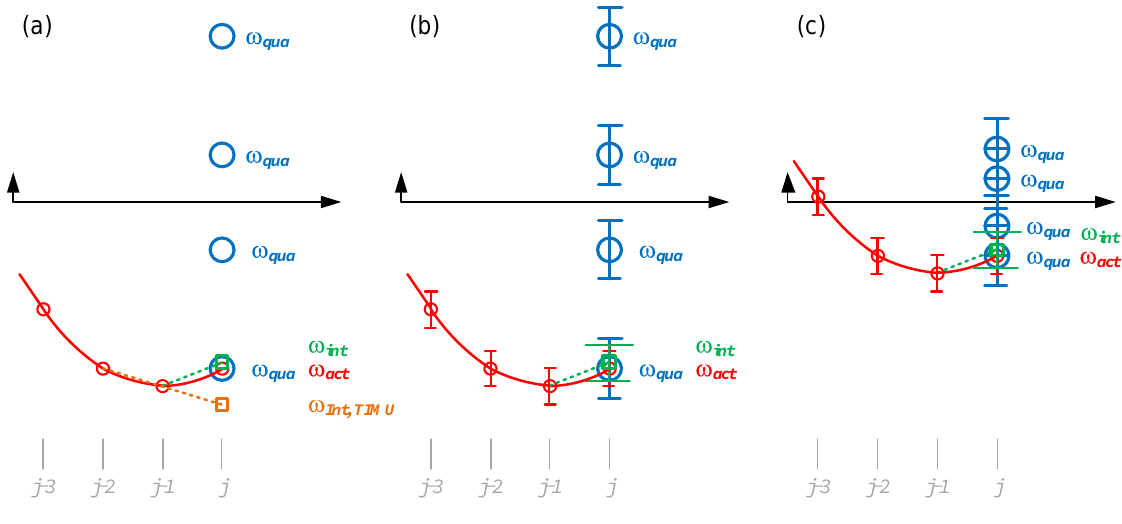
Figure 3. Various scenarios of selecting the correct angular velocity from the eight candidates deriving from the quadratic method: ( a ) “perfect world” with no estimate error, the true angular velocity (red line) is precisely sampled (red circle). The initial guess derived from integration method is represented in green color. ( b ) Normal situation where all computed data have certain variances (shown in error bar). ( c ) Normal situation when the magnitude of the angular velocity is small and the correct solution is hard to